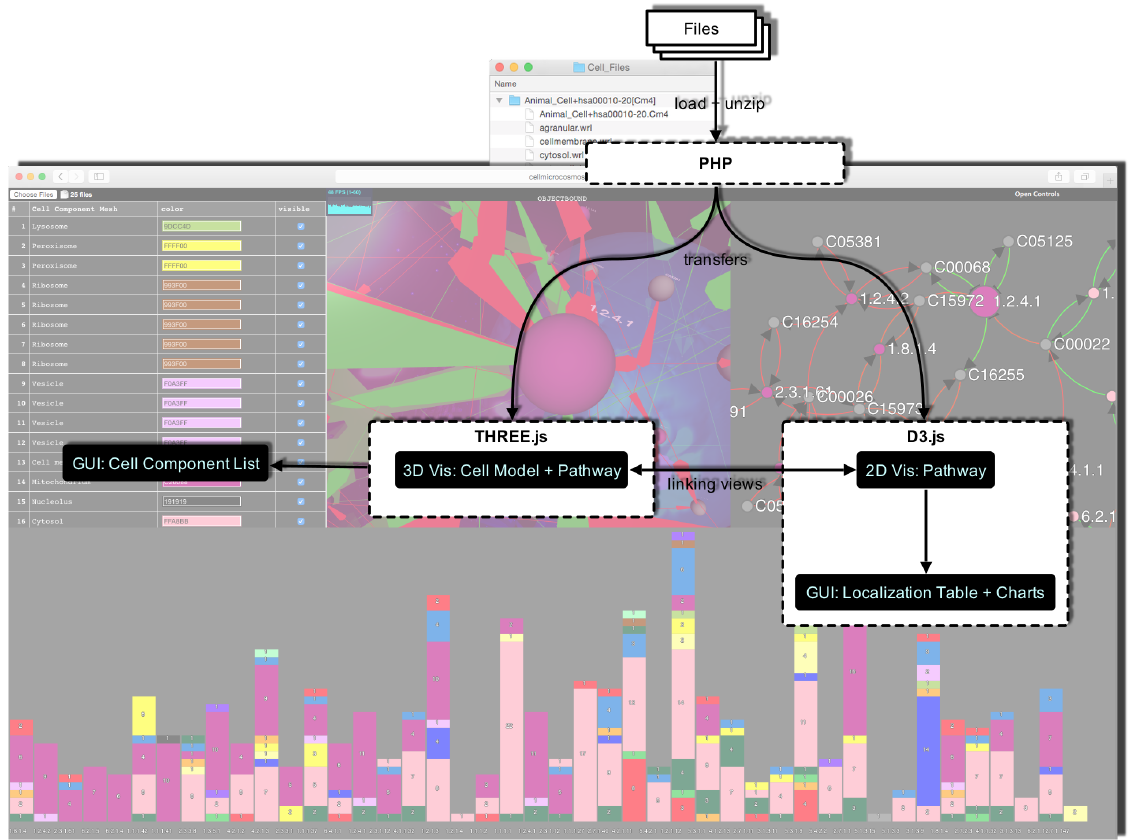
Figure 1: The three-tier Architecture of CmPIweb: PHP, Three.js, and D3.js. Details on the file loading process can be found in Figure